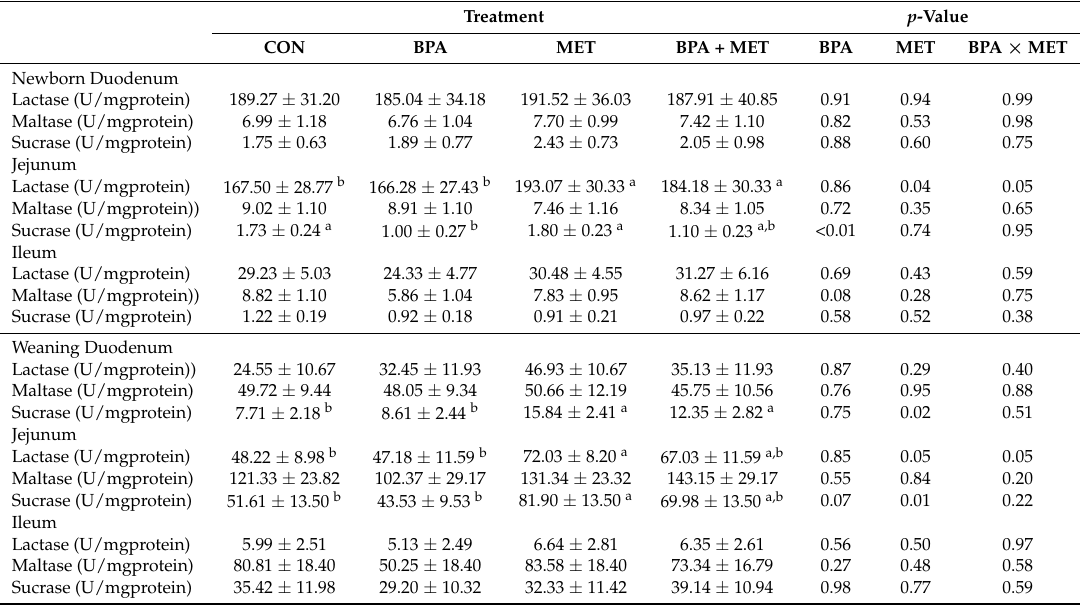
Table 6. Effect of maternal methyl donor or bisphenol A supplementation during gestation on intestinal enzyme activity in newborn and weaning